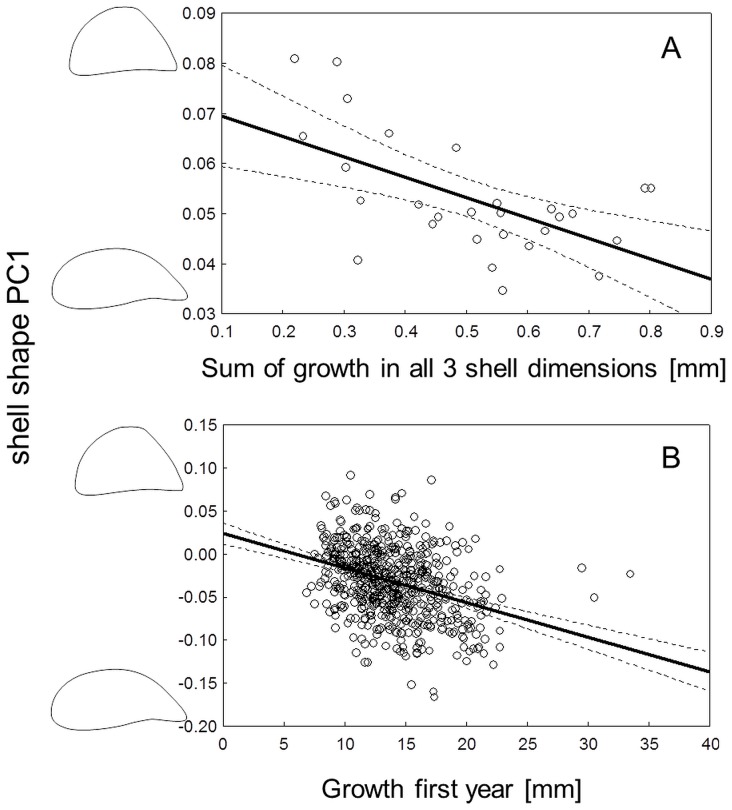
Shell shape and growth are correlated in zebra mussels.
A: experimental data as mean growth (measured in mm increase in the 3 shell dimensions length, height, and width) in relation to the corresponding shell shape as means from the 28 experimental tanks with 16 mussels each. B: field data as individual growth in the first year post settlement in relation to individual shape of 556 mussels. The contours on the y-axis depict ±2SD of the mean of PC1. Dashed lines denote 95% confidence intervals for the fit.